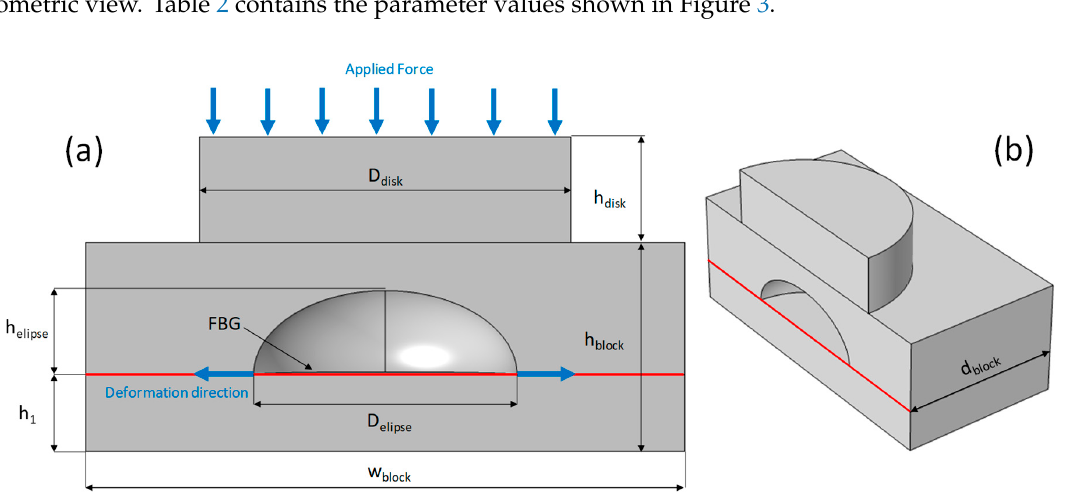
Figure 3. A 3D model of the strain sensor considered in the experiments with its characteristic dimensions. ( a ) Front view and ( b ) isometric view (half sensor).